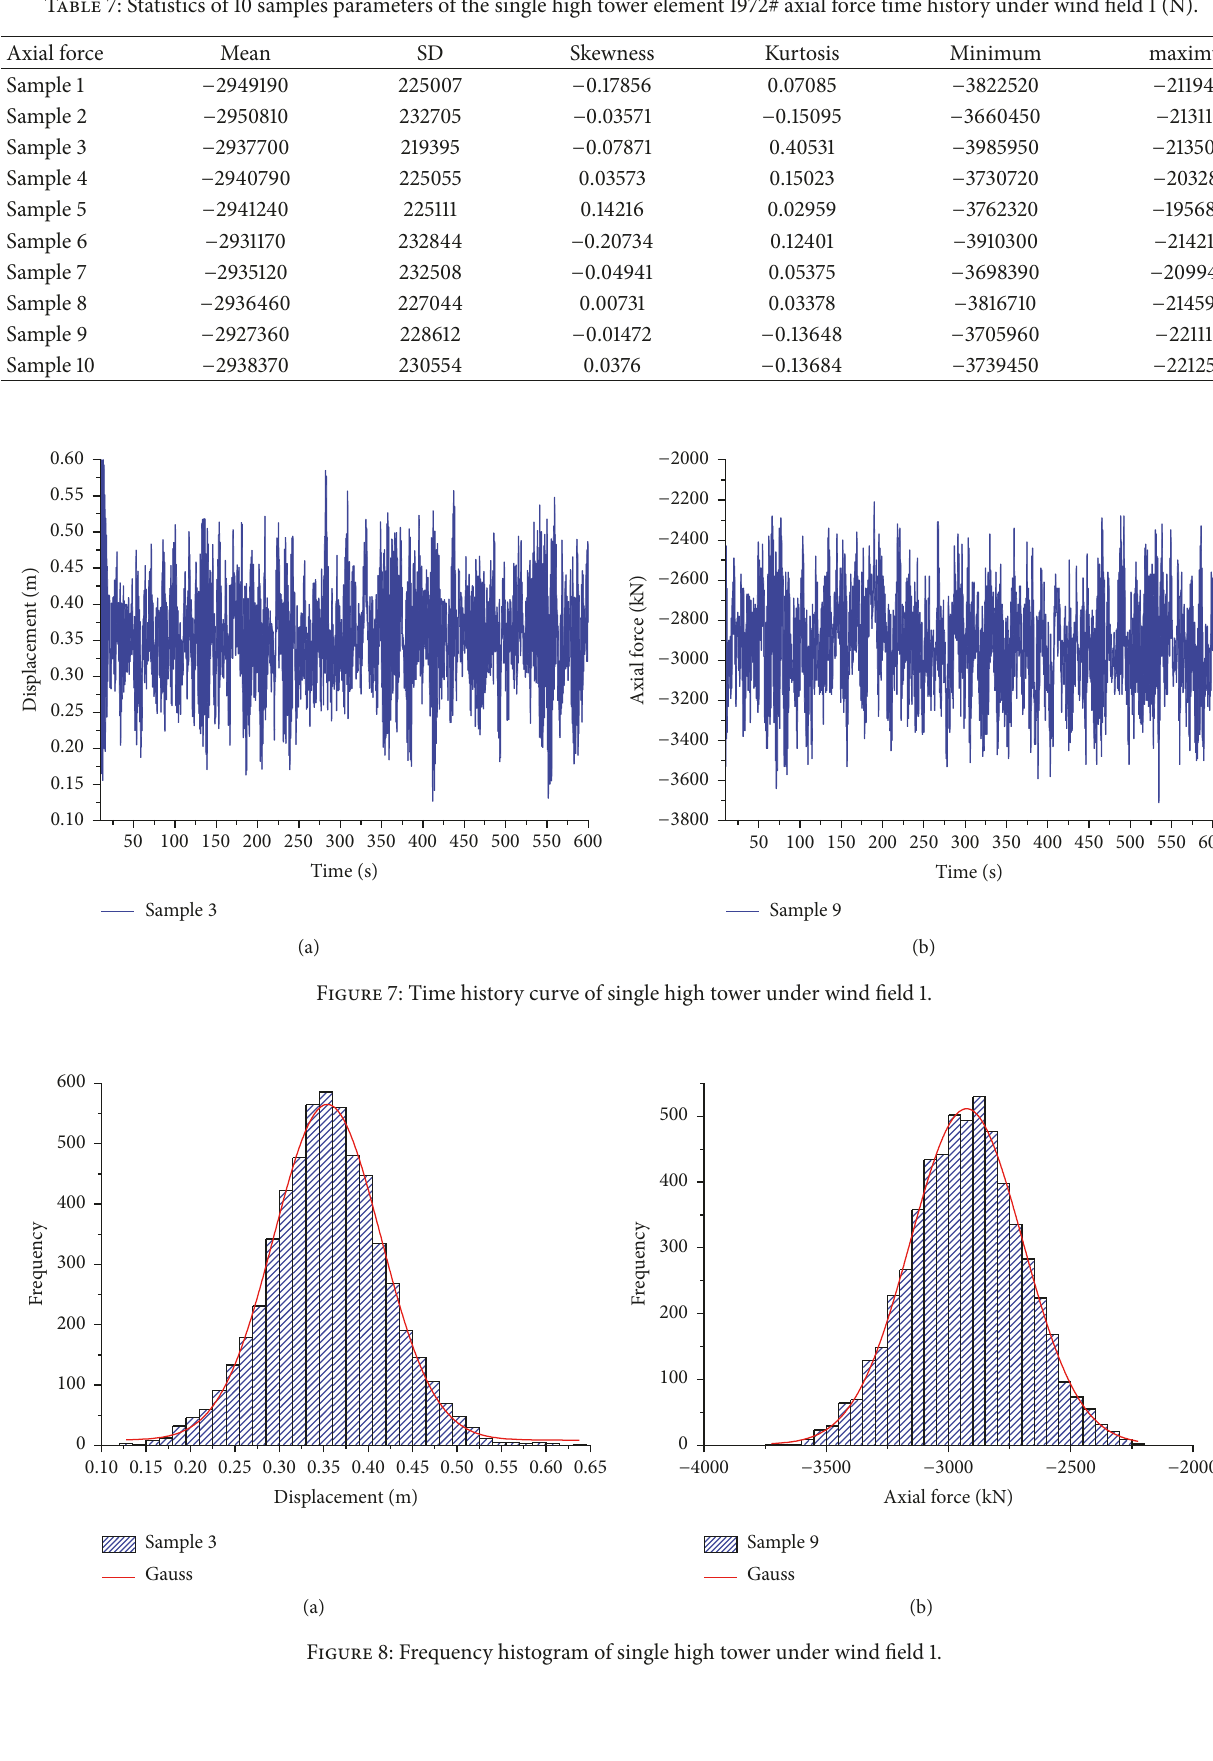
Table 7: Statistics of 10 samples parameters of the single high tower element 1972# axial force time history under wind field 1 (N).